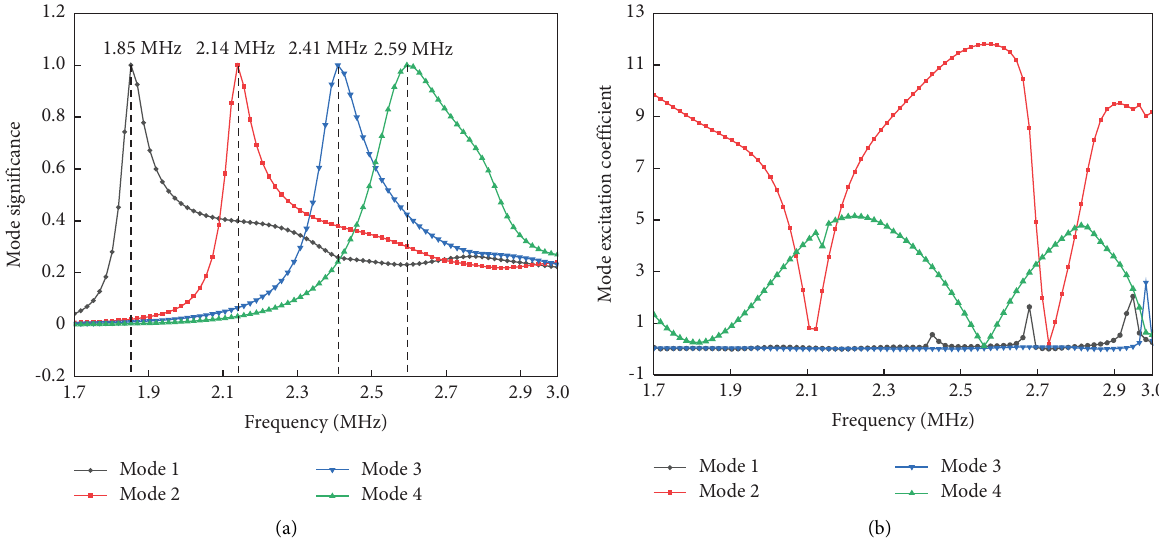
Figure 9: Variation with the frequency of mode signifcances and mode excitation coefcients. (a) Mode signifcances. (b) Mode excitation coefcients.